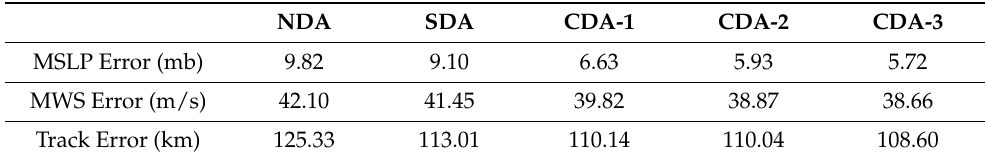
Table 6. The average error of minimum sea level pressure (MSLP), maximum wind speed (MWS), and track,